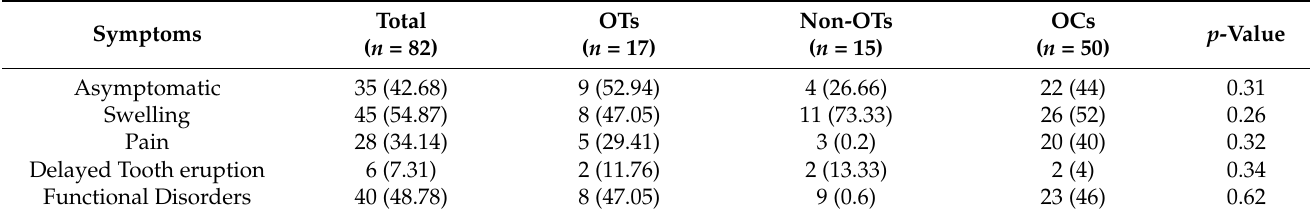
Table 3. Symptoms in pediatric jawbone lesions.